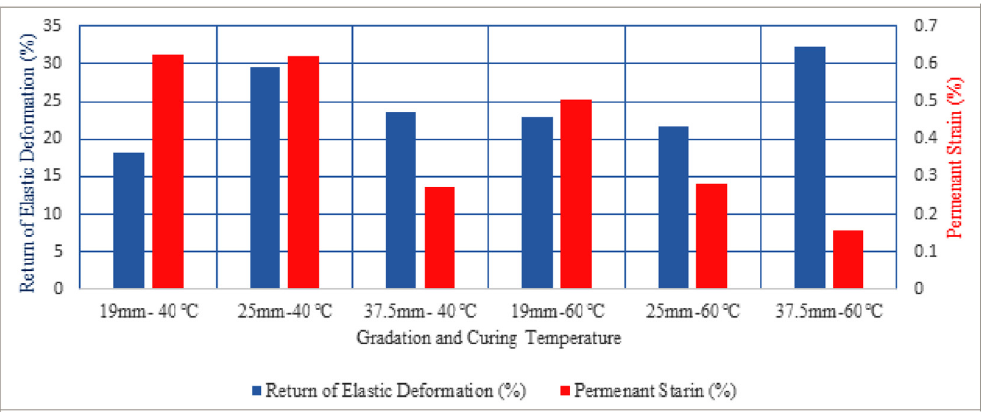
Fig. 3. Permanent strain and return of elastic deformation of recycled mix in static creep